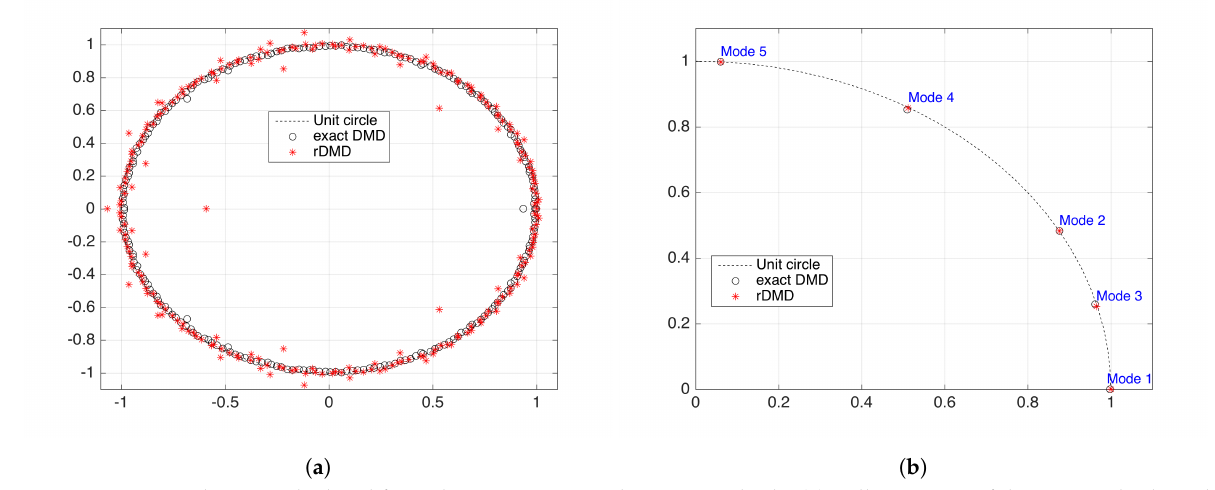
Figure 11. Eigenvalues λ i calculated from the exact DMD and rDMD methods. ( a ) Full spectrum of the two methods with projected space dimension L = 239 and ( b ) shows the first five modes. The mode selection is based on the comparison of the tidal periods with period of the DMD modes.